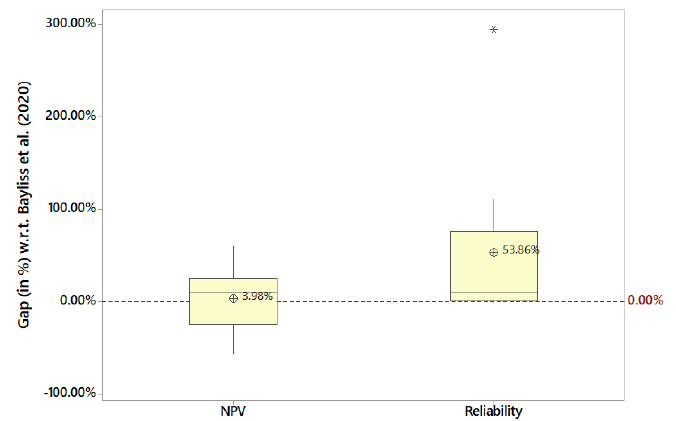
Figure 4. Boxplot comparison of NPV and reliability results w.r.t. a previous